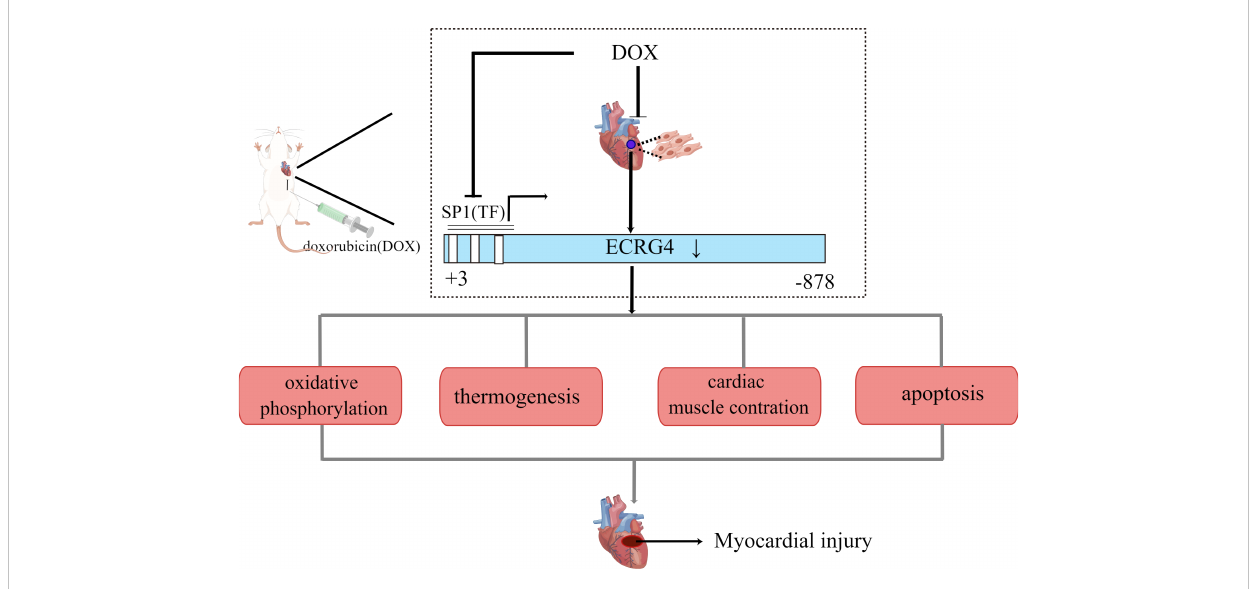
FIGURE 3 ECRG4 is involved in the mechanism of doxorubicin induced myocardial injury. Figure shows the 5 ’ UTR gene sequence of rat ECRG4 -878/+3, which contains 3 potential SP1 transcription factors. Doxorubicin inhibited the expression of SP1 and reduced the binding of SP1 to the rat ECRG4 promoter, thereby decreasing the expression of ECRG4. Cardiomyocyte-speci fi c loss of Ecrg4 signi fi cantly enriched the DEPs in the signaling pathways (oxidative phosphorylation, apoptosis, thermogenesis, and cardiac muscle contraction, among others) commonly involved in DOX-induced